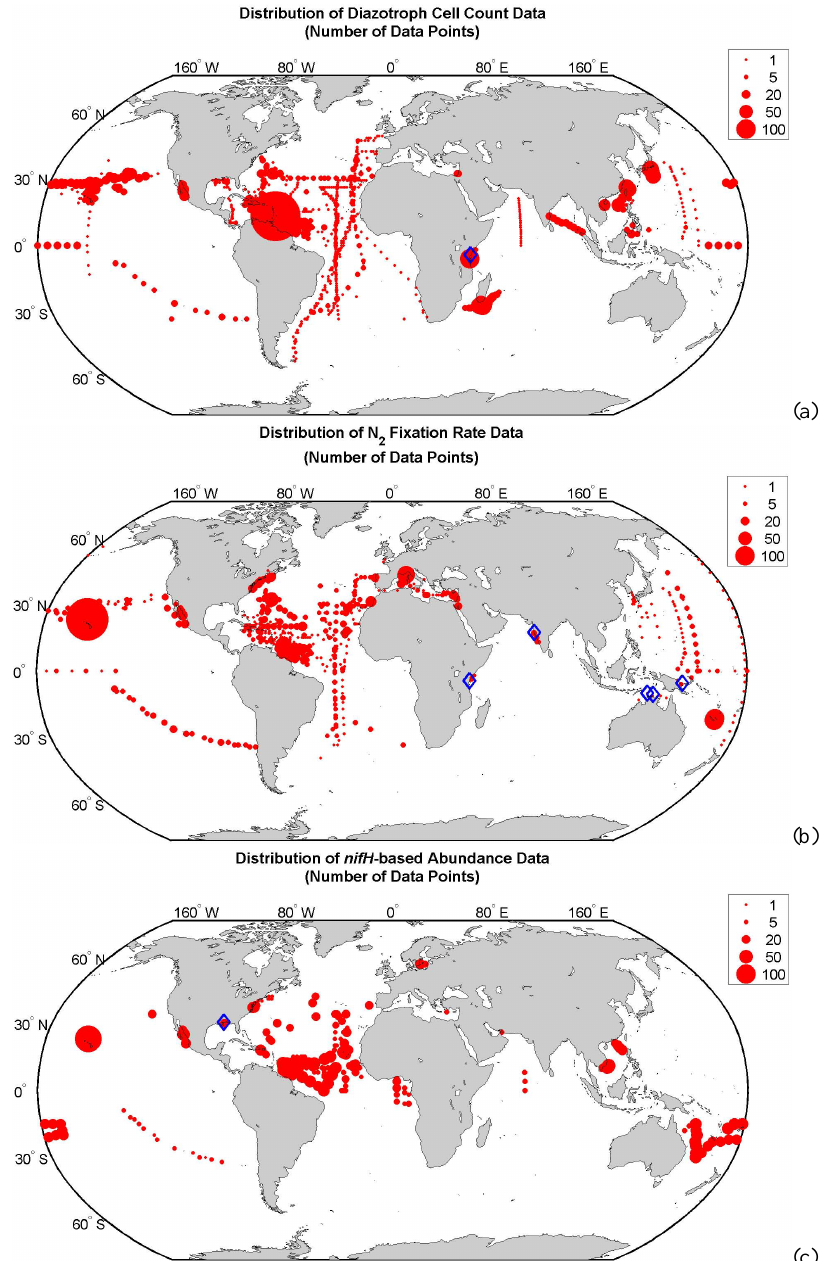
Figure 3. Spatial distributions of collected diazotrophic data in number of data points (binned on to 1 ◦ × 1 ◦ grid), including cell counts (panel a ), N 2 fixation rates (panel b ) and nifH -based abundances (panel c ). Blue diamonds mark the location for the data rejected by Chauvenet’s